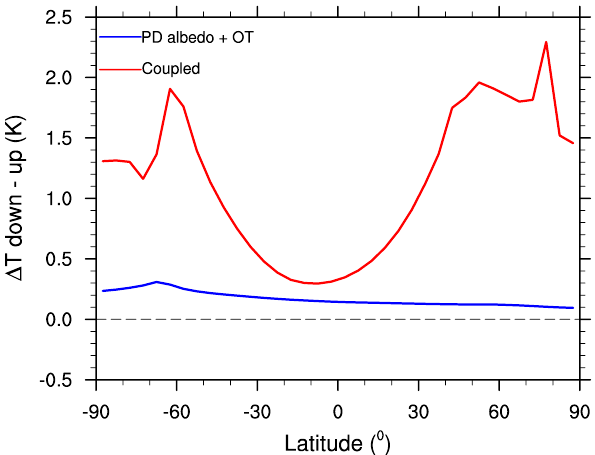
Figure 4. Atmospheric temperature difference at 150ppm between the equilibrium runs (down – up) using the fully coupled set-up (red) and using fixed PD surface albedo and ocean overturning strength